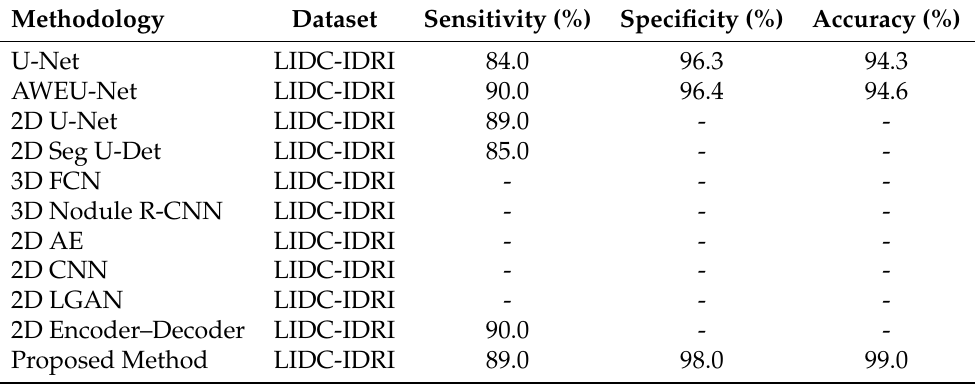
Figure 8. Comparison of the segmentation methods. ( a ) Original image; ( b ) Region Detection (RD); ( c ) Level Set Without Initialization (LSWI); ( d ) Re-initialization Methods (RMs); ( e ) GDRLSE1; ( f ) GDRLSE2; ( g ) GDRLSE3; ( h ) result of the proposed method. Table 2. Result comparison of the proposed method with existing